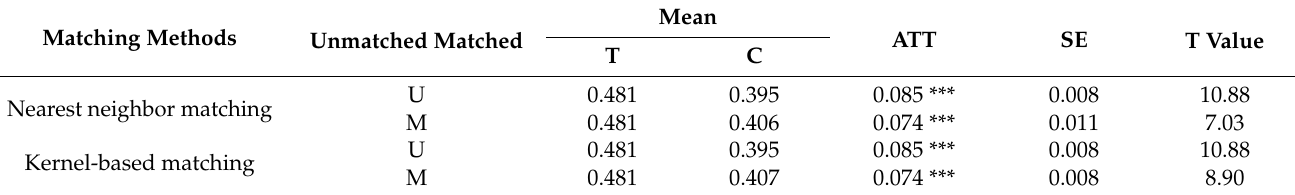
Table 8. The ATT of village level LCP on land